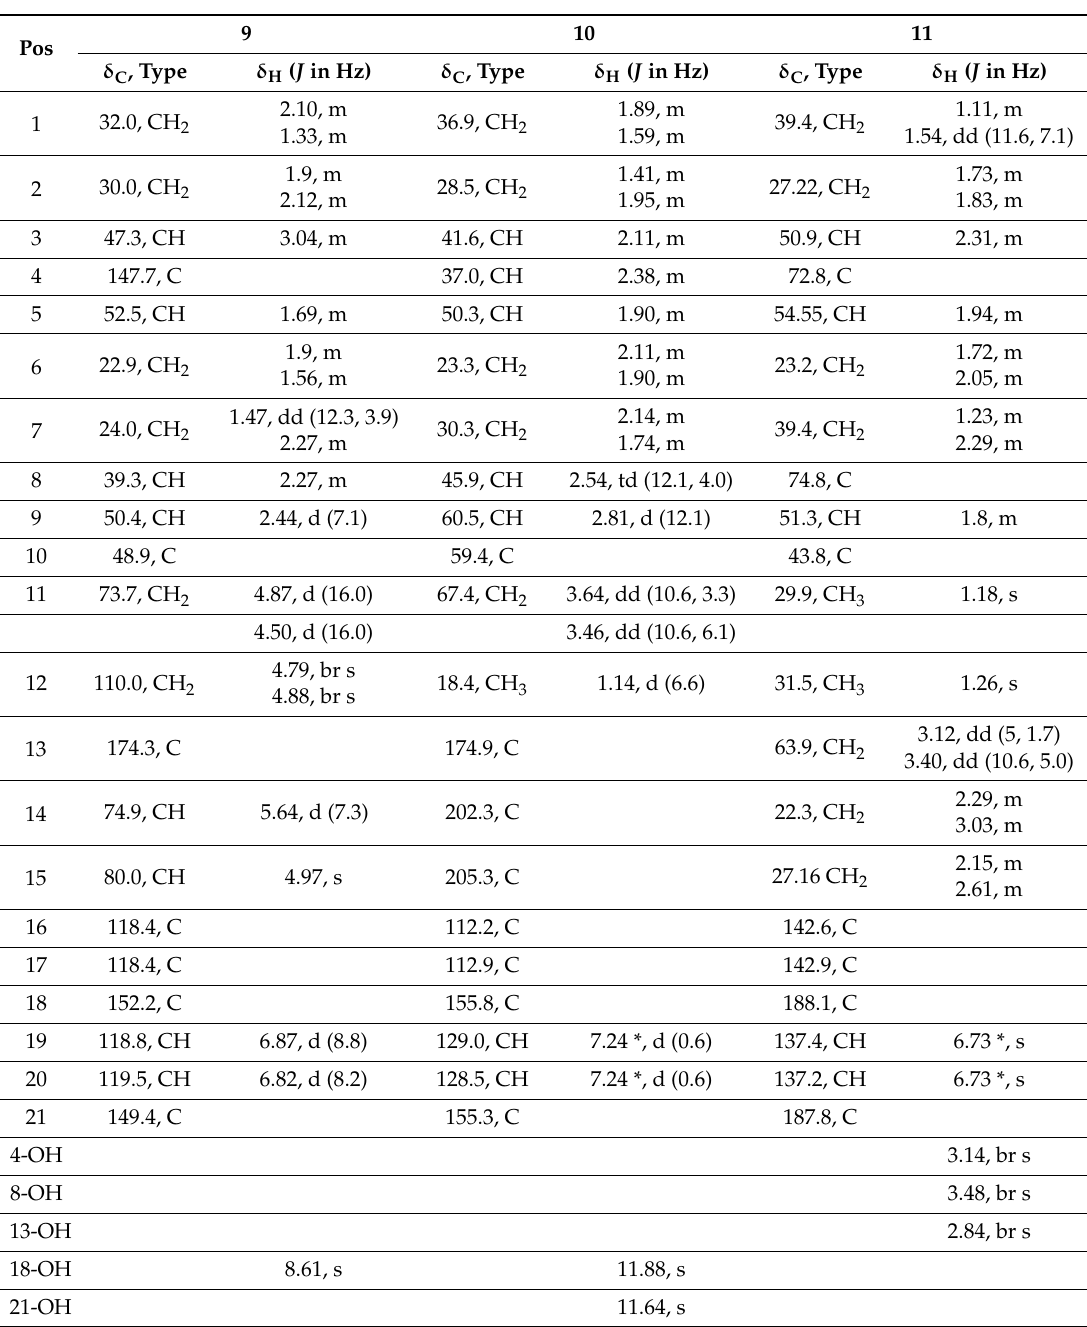
Table 2. 1 H- and 13 C-NMR spectroscopic data ( 1 H 700 MHz, 13 C 176 MHz, CDCl 3 ) for 9 – 10 , and ( 1 H 500 MHz, 13 C 125 MHz, acetone- d 6 ) for 11